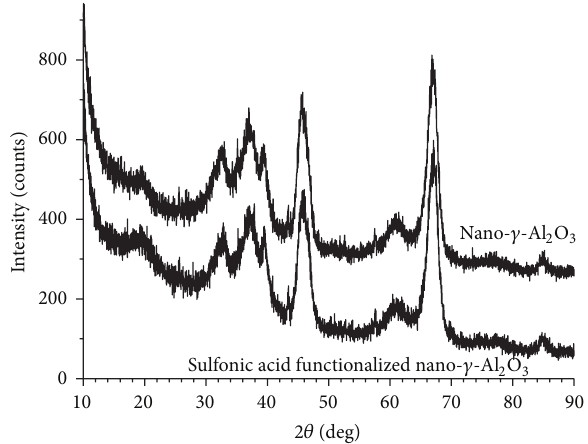
Figure 2: XRD patterns of nano- 𝛾 -Al 2 O 3 (up) and sulfonic acid functionalized nano- 𝛾 -Al 2 O 3 (down).